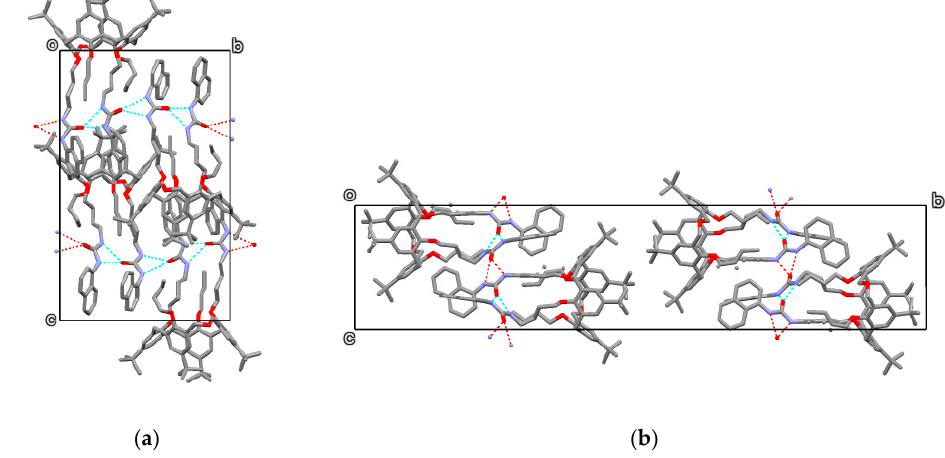
Figure 2. Crystal packing in the unit cells of ( a ) 5a and ( b ) 5b . In both cases the crystal packing is characterized by inversion-related antiparallel chains of bifurcated H-bonds. In 5a , each molecule in the chain is generated by a 2 1 screw operation and the chains are parallel to the b -axis. Each chain is composed of molecules with the same chirality and the antiparallel chain is composed of opposite chirality. In 5b , the molecules in each chain are generated by the glide planes and the chains are parallel to the a - c cell diagonal. The atomic species are represented in CPK colours. Hydrogen atoms are omitted for clarity.